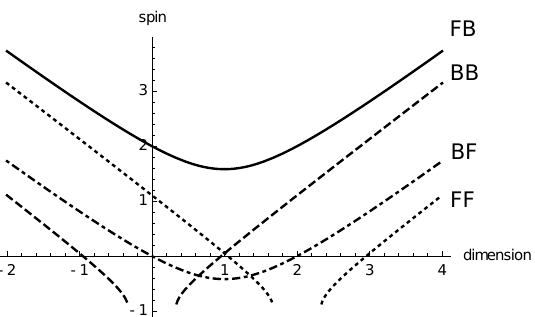
Figure 15 . The spin as a function of dimension J ( E ) for the leading Regge trajectory appearing in the correlation function of primaries ( (cid:16) = (cid:22) (cid:16) = 0) in various channels, for b q = 3. The FB and BF curves di(cid:11)er by two units of spin, and the BB and FF curves di(cid:11)er by two units of dimension. In between the gaps in the BB and FF curves, the spin is